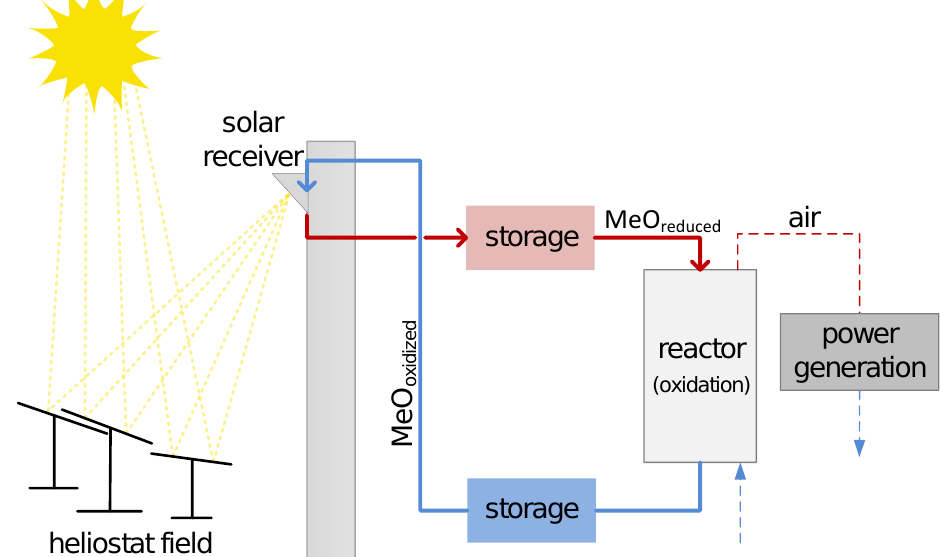
Figure 1. Concept of thermal energy storage based on metal-oxide particles for solar tower applications, including a high-temperature and low-temperature storage tank for decoupling of the system capacity and thermal power